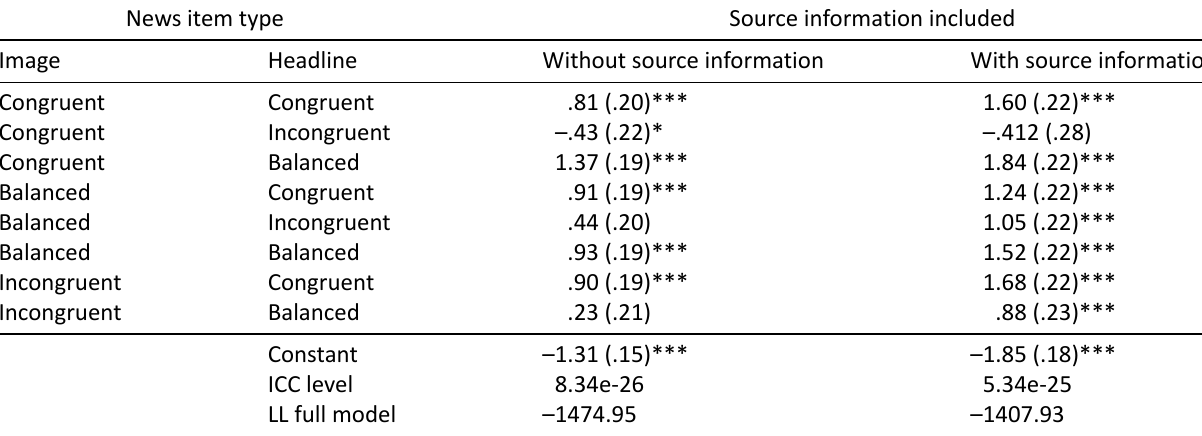
Table A2. Refugees context, logistic multilevel models explaining peoples’ selection of a news item, source and no source. News item